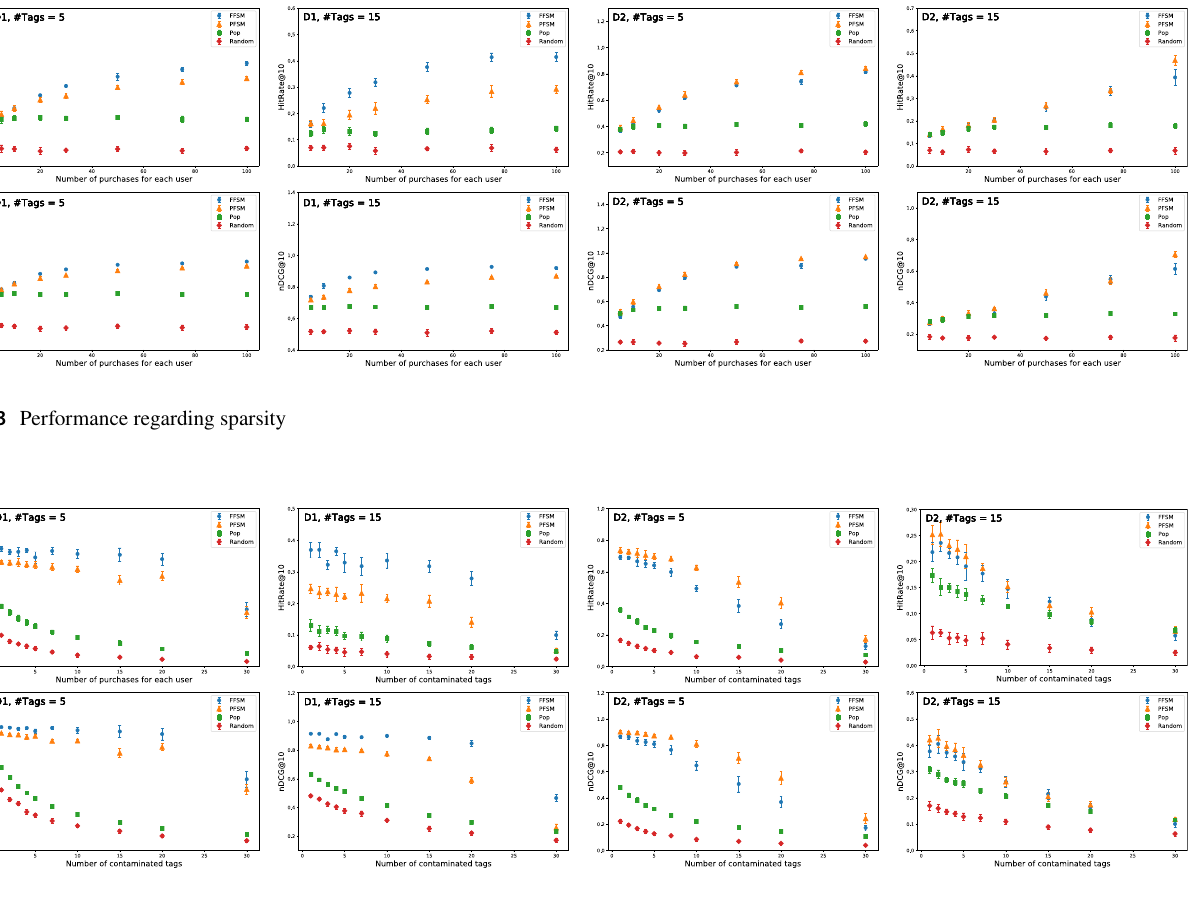
Fig. 4 Model performance regarding tag